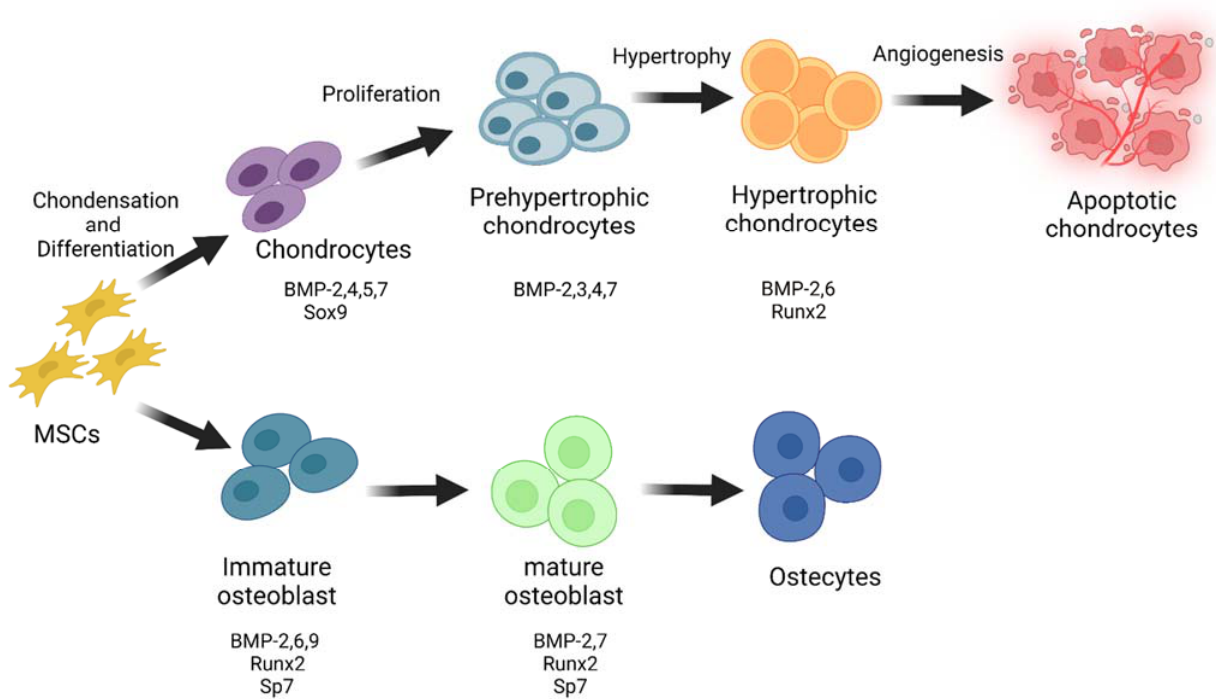
Figure 2. Roles of BMPs in skeletal development. BMP ligands are multifunctional growth factors that are important in a range of biological processes but are best recognised for inducing bone formation. MSCs give rise to chondrocytes, which go through a series of differentiation processes. BMPs govern various phases of chondrocyte differentiation by regulating the expression of Sox9 and Runx2. Sox9 promotes the proliferation and differentiation of MSCs into chondrocytes, while Runx2 induces chondrocyte hypertrophy. Moreover, BMPs promotes osteogenesis by enhancing Runx2 and Sp7 transcription factor activity. “Created with BioRender.com (Accessed on 31 January 2022)”.